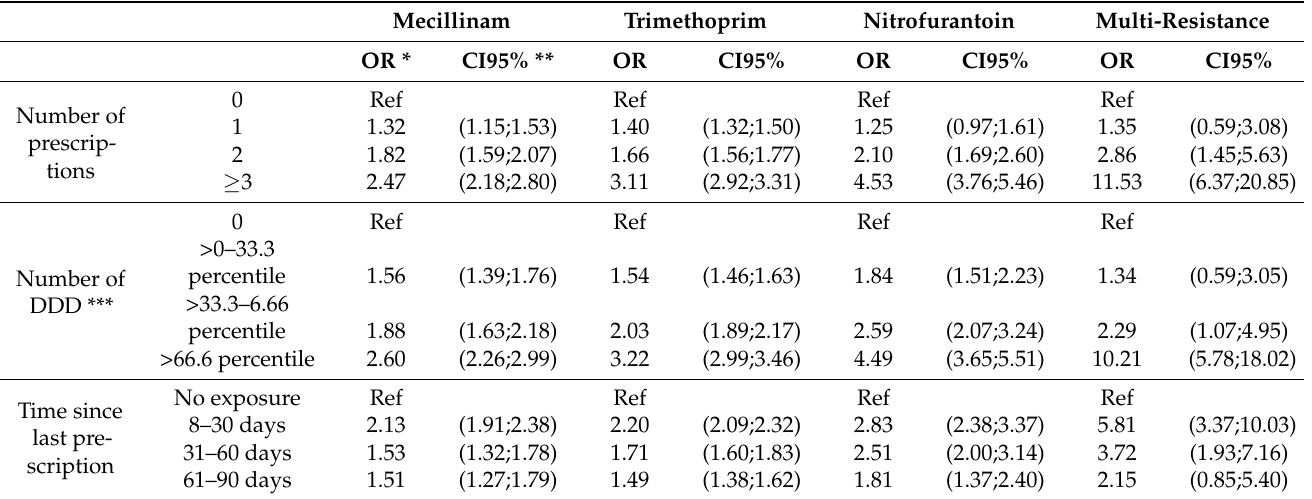
Table 2. Adjusted analyses of total exposure to antibiotics (number of prescriptions and DDD) and time since last prescription, and OR of resistant E. coli